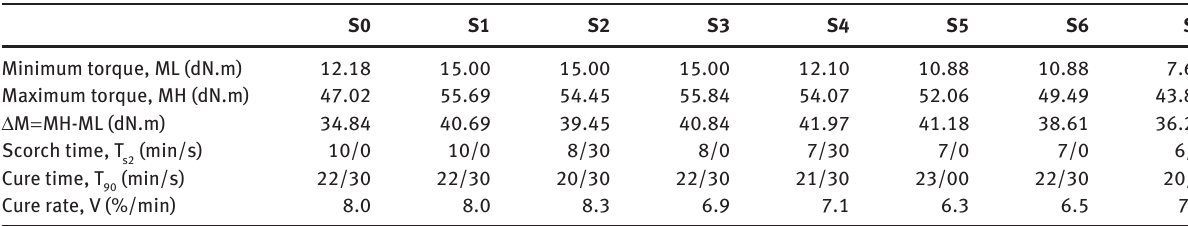
Table 3 Curing properties of the investigated rubber